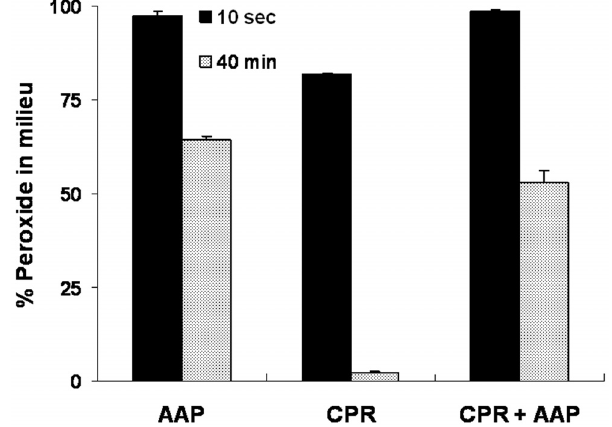
Figure 2. Characterizing the oxygen activation and peroxide depleting roles of CPR. 2a: Theperoxidedepletingnatureof CPR is depicted. The trace (triangles) shows that CPR does not need NADPH for depleting peroxide. The initial concentration of components were- (CPR) =230 nM, (NADPH) =164 m M & (H 2 O 2 ) =40 m M. 2b: Comparison of CPR’s peroxide depleting function with an approximately equal concentrationofHRP is shown. Catalase (160 nM) depleted peroxide to non-detectable levels within the first few seconds of incubation itself and hence, the trace is not shown. Initial concentrations were- (CPR) = (HRP) =160 nM, (H 2 O 2 ) =100 m M.